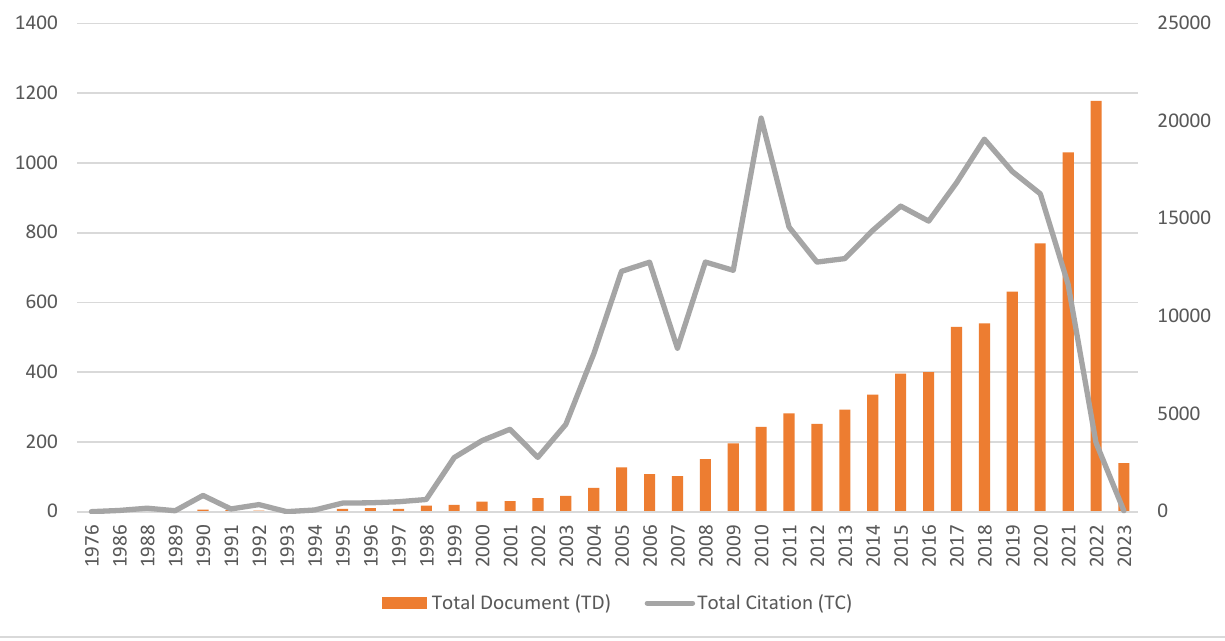
Figure 3. Total document and total citation.